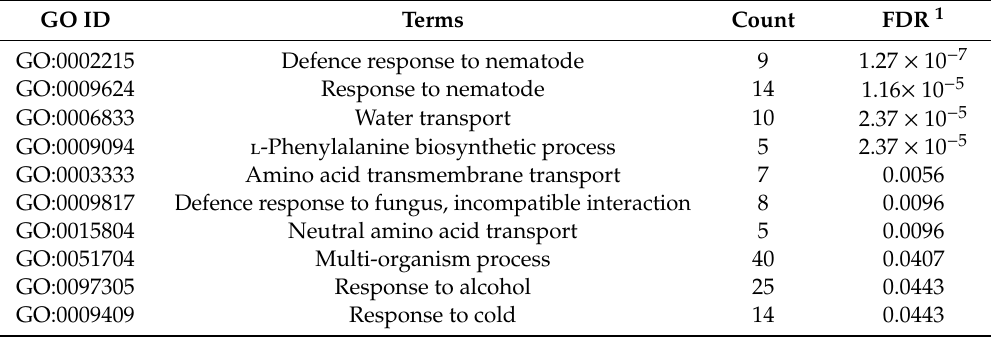
Table 3. Gene ontology (GO) enrichment of methyl salicylic acid-specific